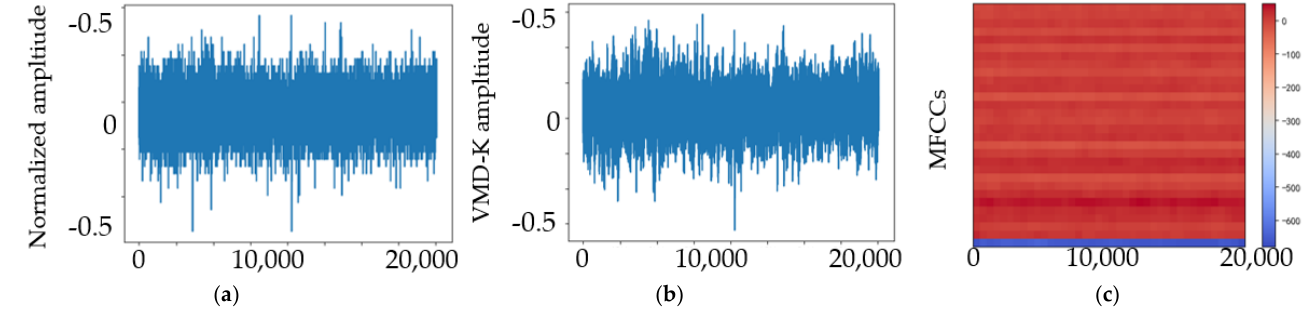
Figure 10. AE signals of the MRE damage state at 20 rpm and 100 kN radial load: ( a ) original signal; ( b ) signal after denoising; ( c ) MFCCs.